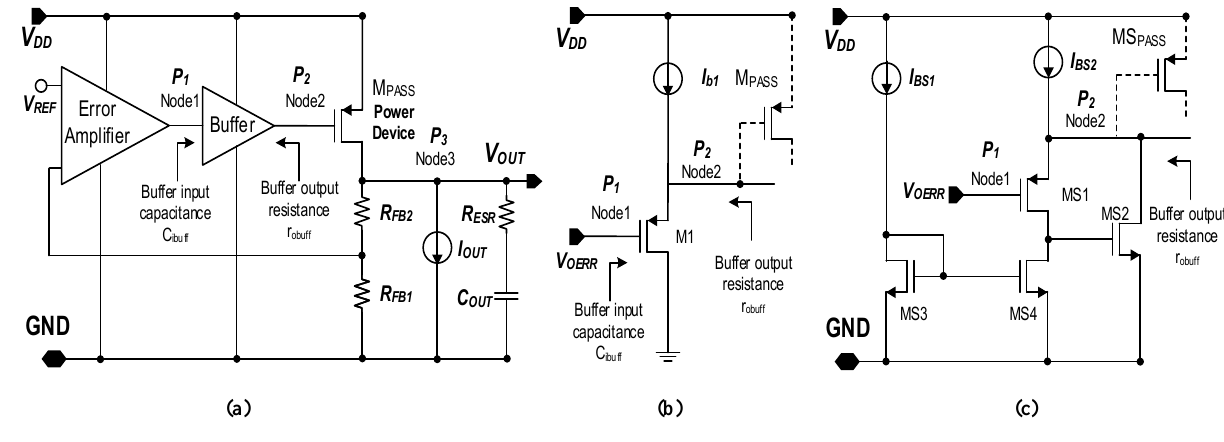
Figure 5. ( a ) Block schematic of conventional low drop-out (LDO); ( b ) source follower buffer; ( c ) source follower with shunt